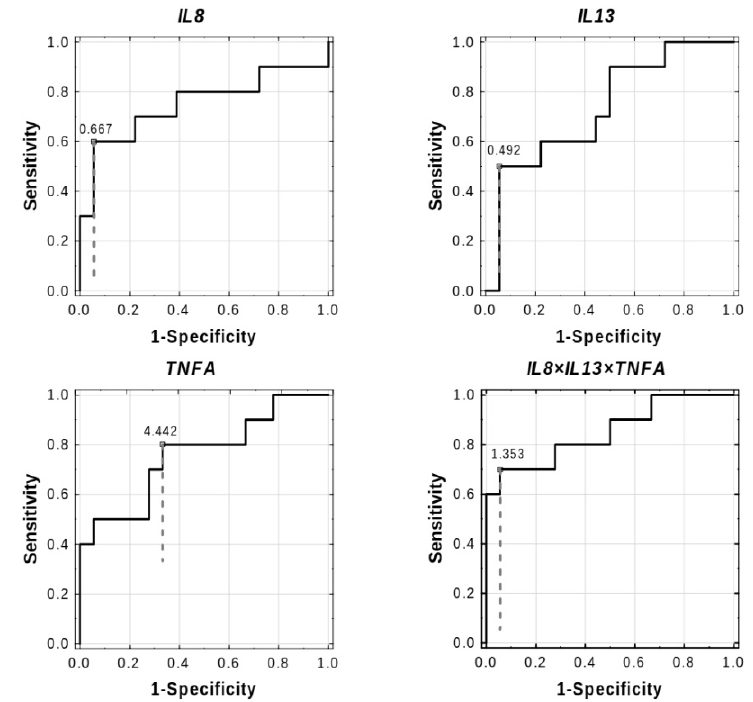
Figure 5. ROC curve analyses for the expression of the three genes ( IL8 , IL13 , and TNFA ), individually and in combination, for predicting AGT at 1-year postpartum in women with prior GDM. Solid lines represent the performance of each classifier. Diagonal dotted lines represent a reference classifier with the random performance level (AUC = 0.5). The optimal cut-off point (solid circle in white) for the expression of each gene is designated by the Younden index method (vertical dashed lines). The calculated results based on ROC analyses are available in Table 6.